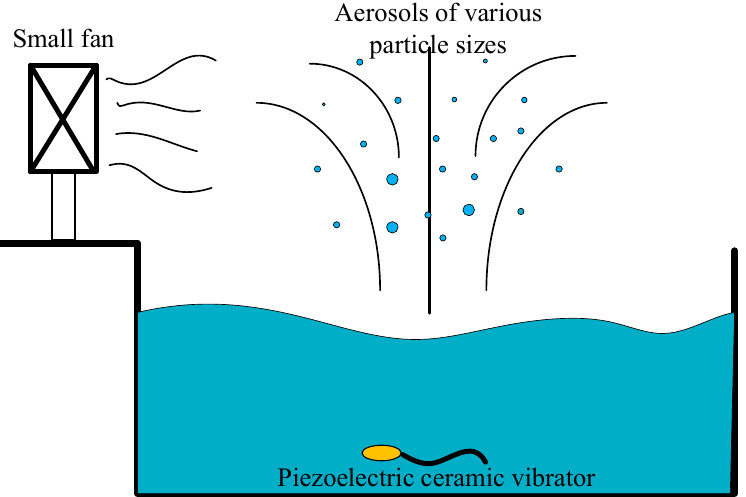
Figure 3. Ultrasonic atomization